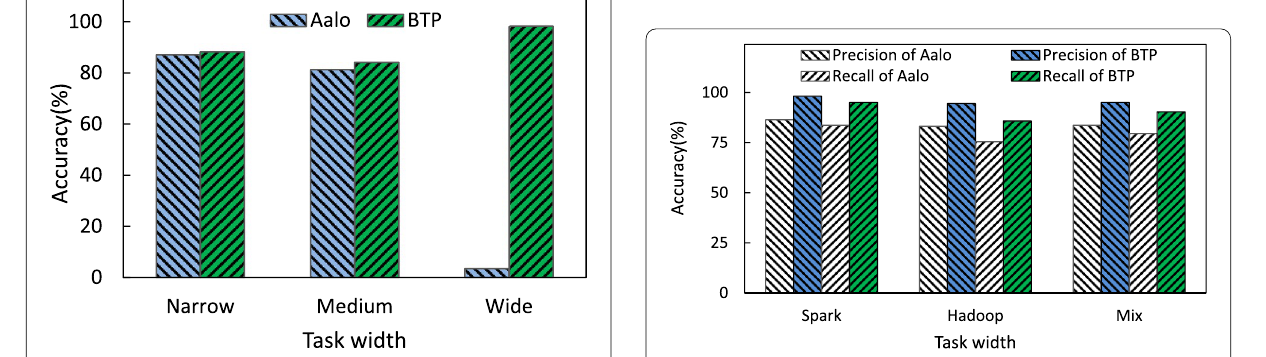
Fig. 9 Accuracy under different task widths Fig. 10 Accurancy under different task